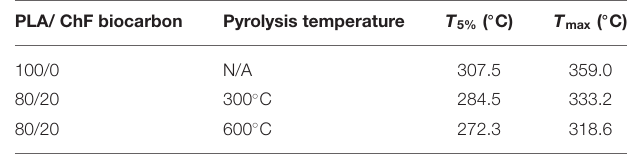
TABLE 6 | TGA results for PLA and biocarbon composites in nitrogen